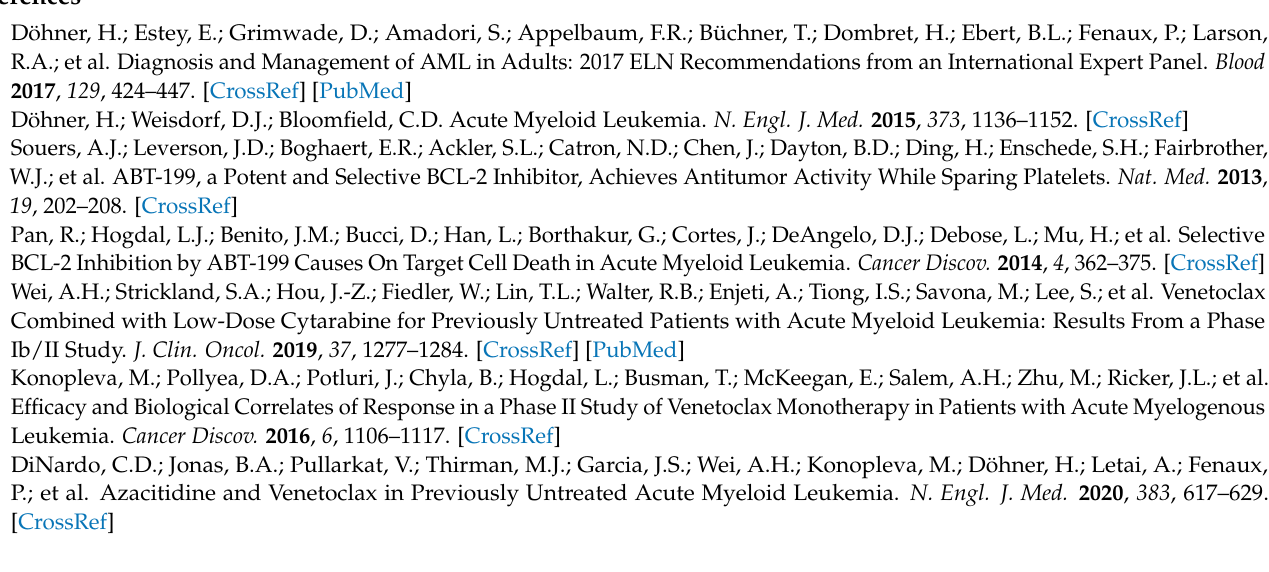
Figure S2. Decreased expression of AMPK subunits by venetoclax in AML; Figure S3. AMPK degradation is due to on-target caspase activation by venetoclax; Figure S4. AMPK contributes to the pro-apoptotic activity of venetoclax in AML; Figure S5: Original